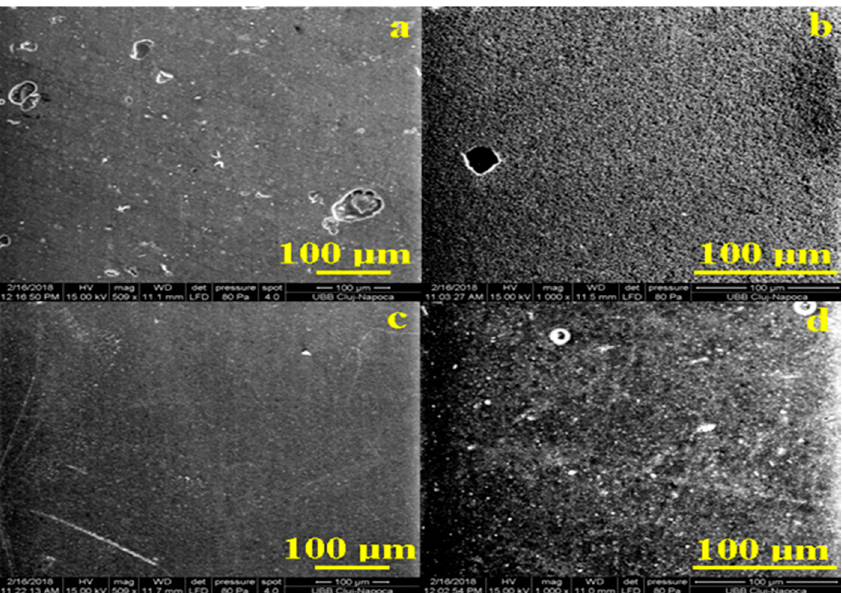
Figure 2. SEM images of the initial samples: ( a ) Adoro, ( b ) Variolink, ( c ) Relyx, and ( d ) Solidex captured with 500× and 1000× magnitude.